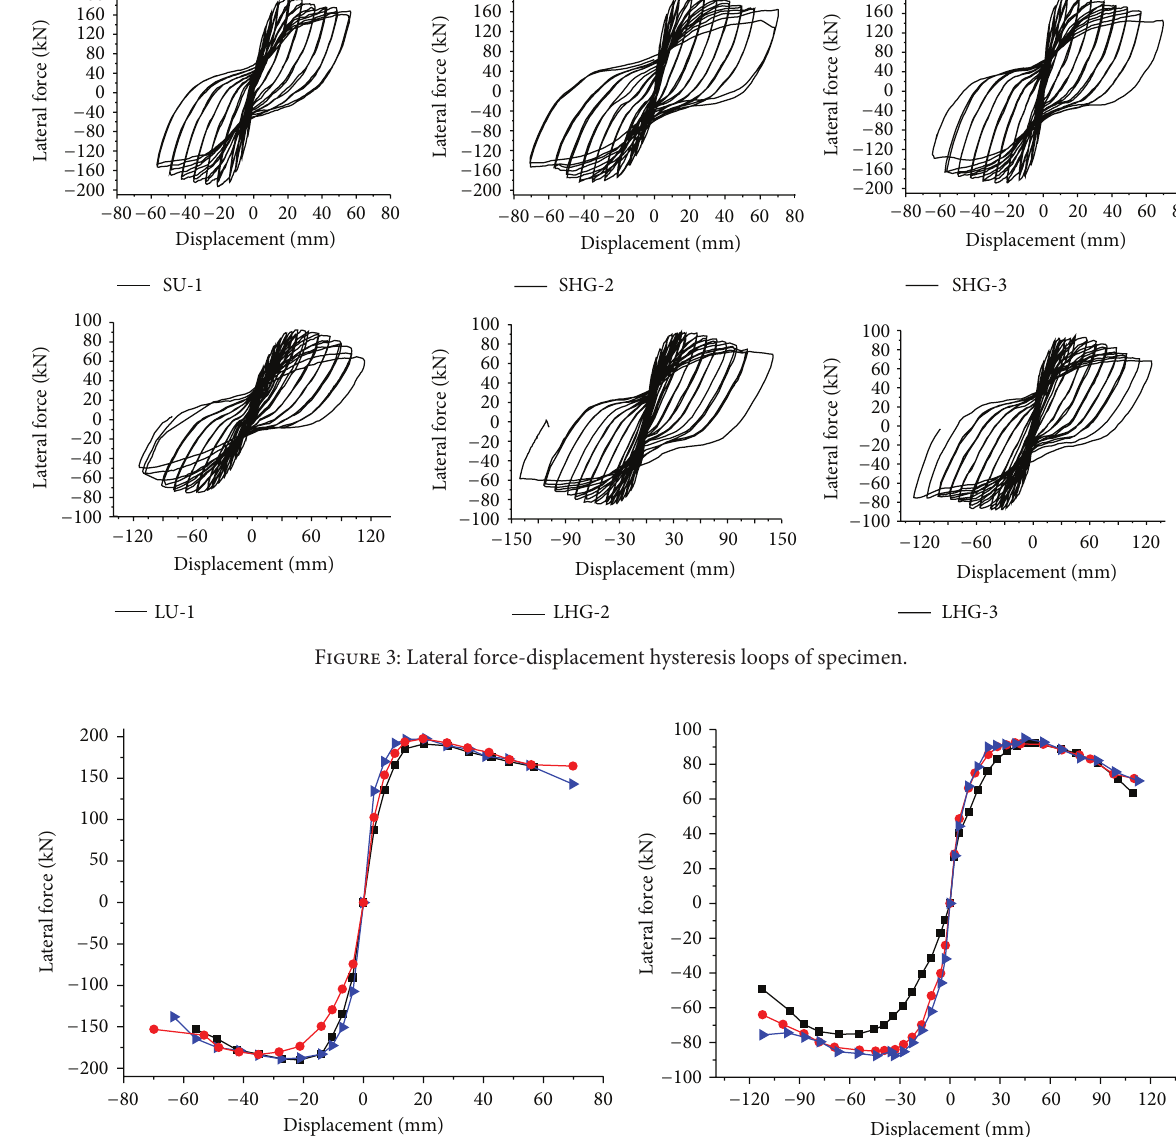
Figure 4: Skeleton curves of specimens (a) 𝐿/𝑏 = 4 and (b) 𝐿/𝑏 = 8